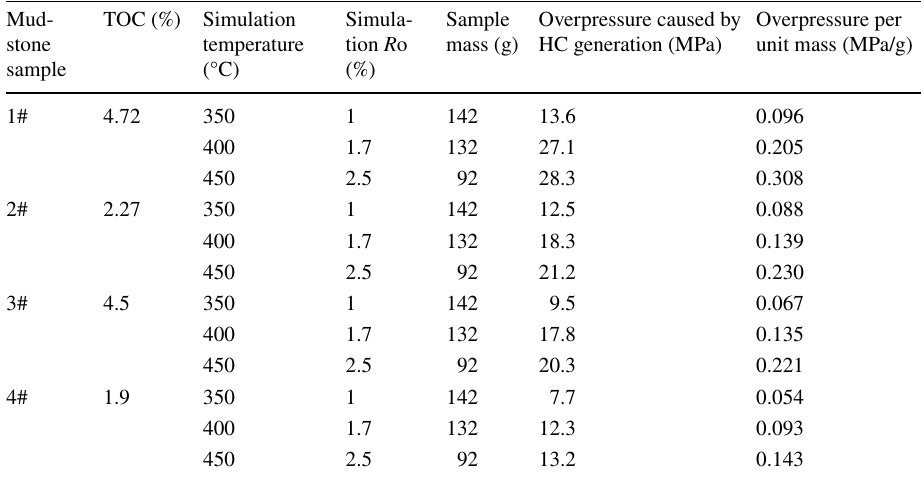
Overpressure per unit mass (MPa/g)